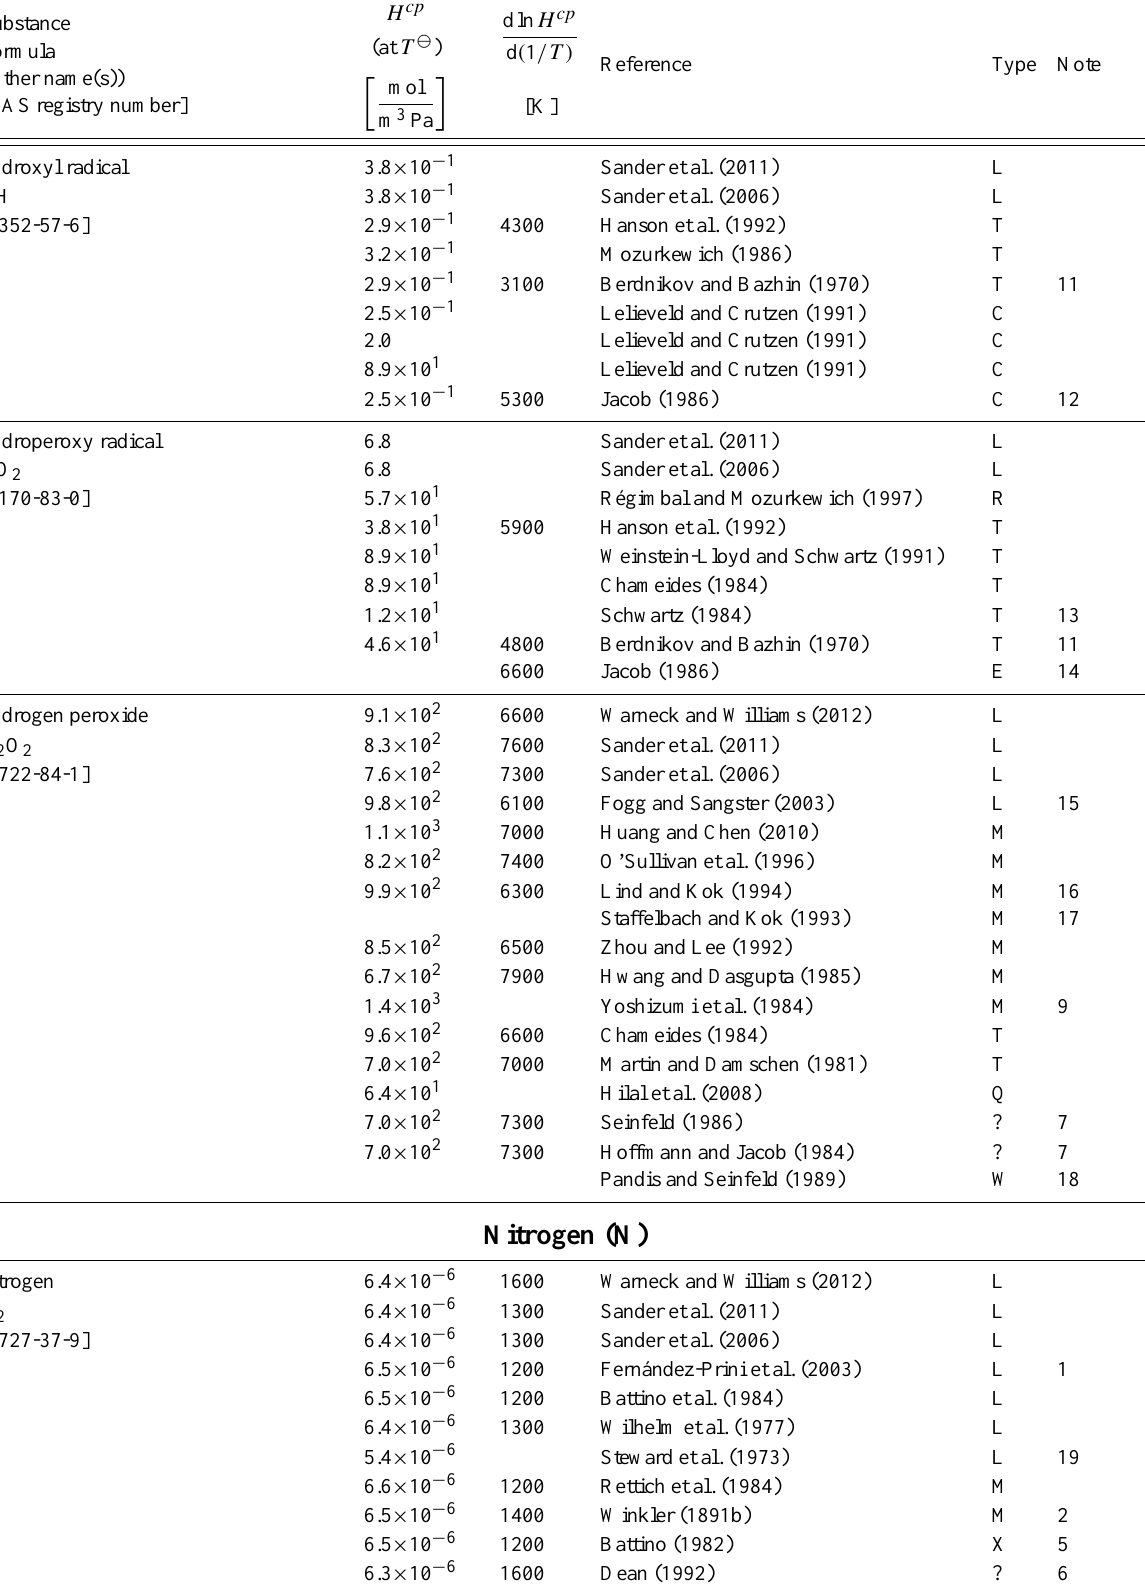
Table 6: Henry’s law constants for water as solvent